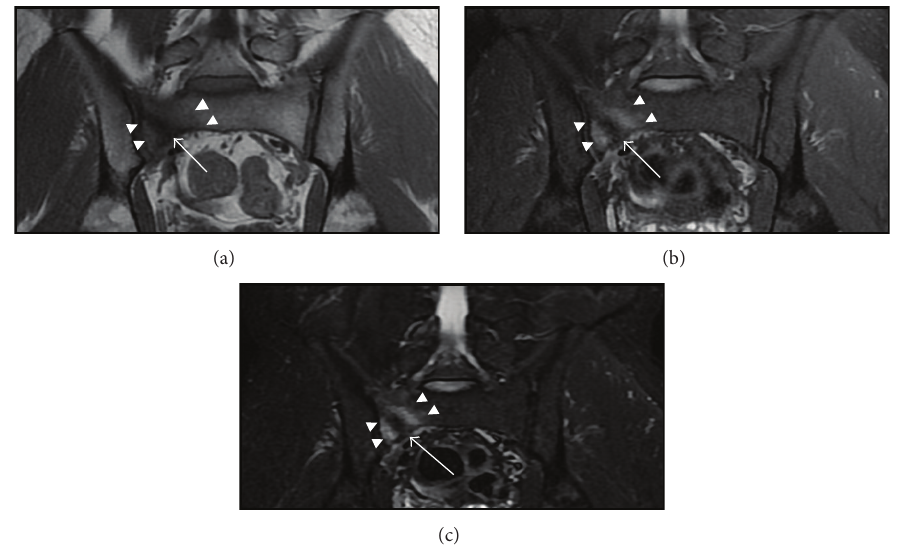
Figure 1: The coronal T1-w (a), STIR (b) and fat-suppressed T2-w (c) MR images of the pelvis depict an area of bone marrow edema in the right sacral ala (arrowheads) surrounding a low signal intensity obliquely oriented vertical fracture line